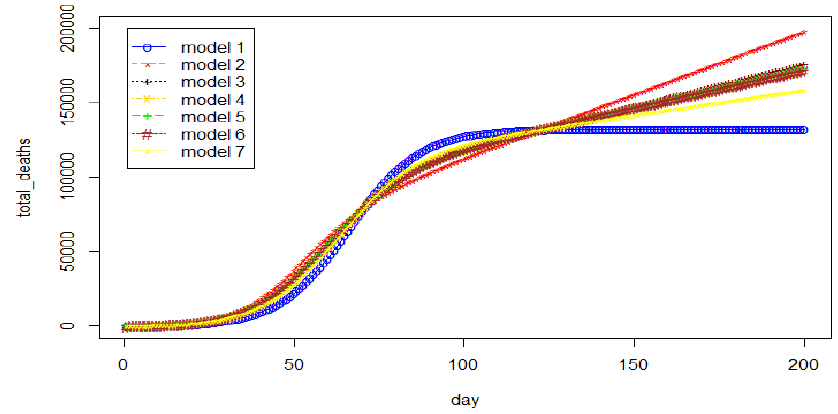
Figure 4. The estimated cumulative number of deaths vs. day in the United States